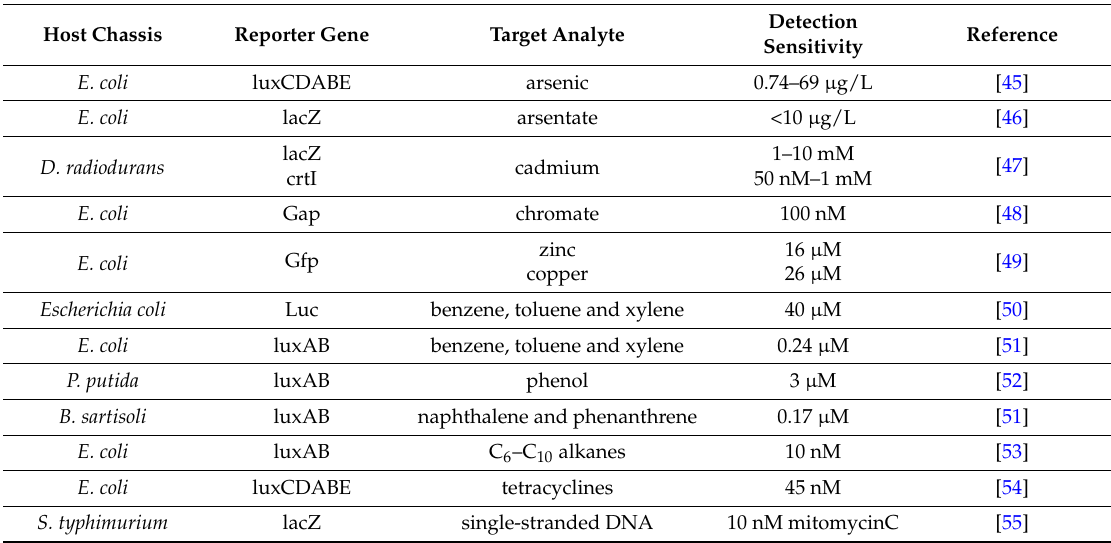
Table 2. A comparison of the sensitivities for different types of whole cell-based